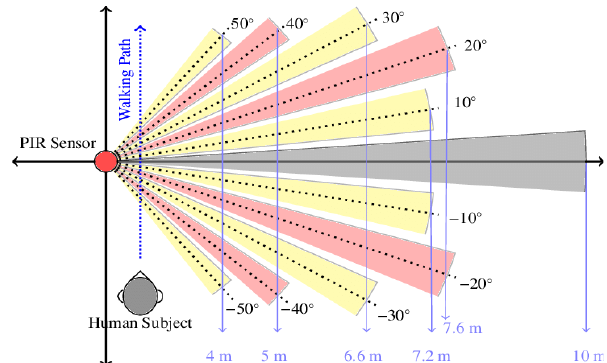
Figure 2. Field of view of PIR sensor